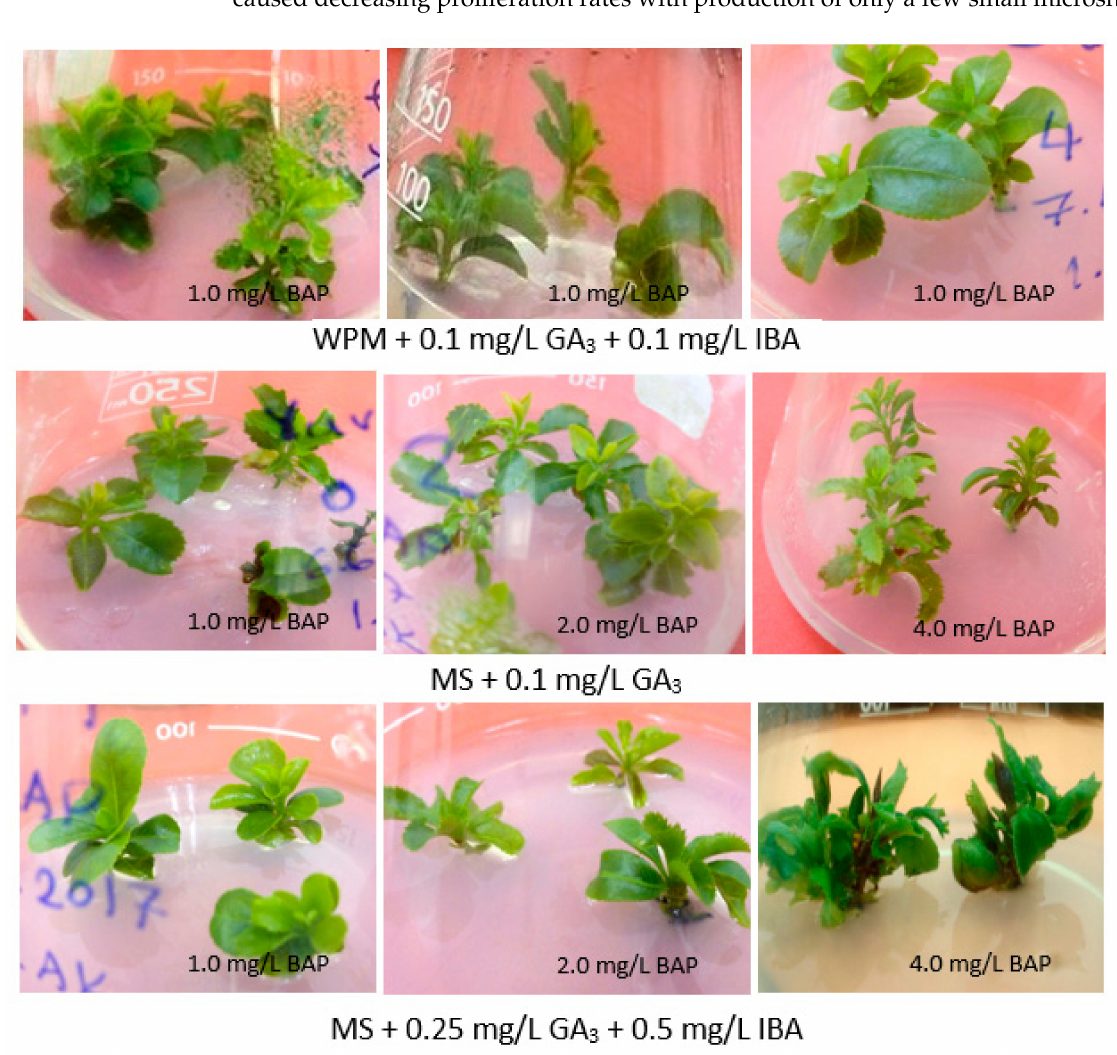
Figure 5. Proliferation stage of YV4 genotype in the WPM and MS media supplemented with different growth